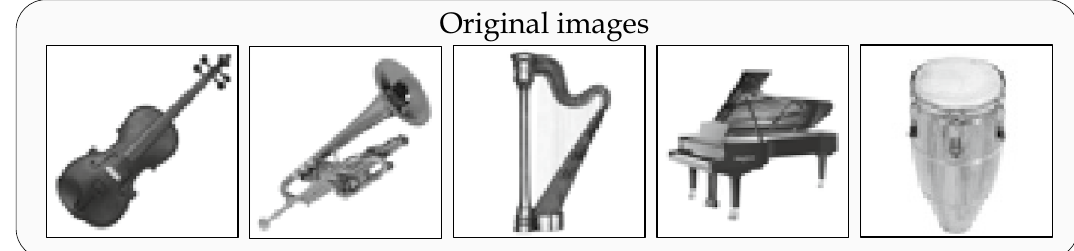
Figure 2. Grayscale images of 64 × 64 pixels displaying classical orchestral instruments that are used for the memory input vectors f 1 , . . . , f 5 . All images were taken from Pixabay.